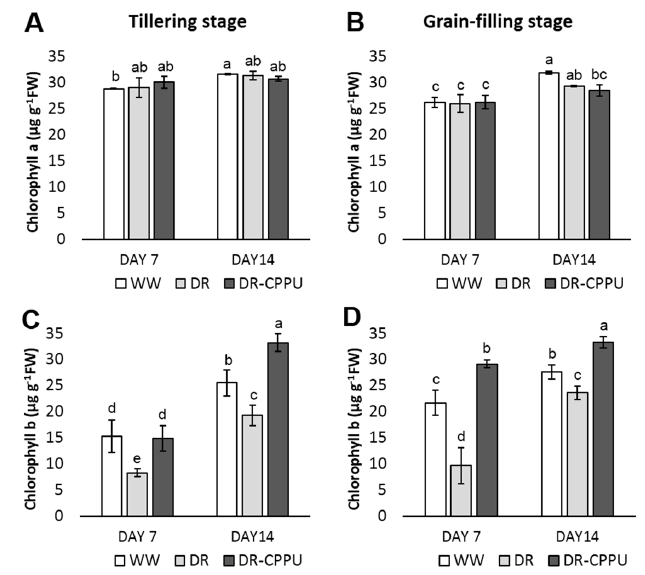
Figure 6. Contents of chlorophyll pigments ( µ g g − 1 FW), Chl a ( A , B ) and Chl b ( C , D ), quantified from rice leaves under di ff erent treatment conditions at tillering and grain-filling stages. WW = Well-watered plants (soil moisture tension of − 15 kPa), DR = Drought stressed plants (Soil moisture tension of − 55 kPa and − 72 kPa at day 7 and day 14, respectively), and DR-CPPU = Drought stressed plants, sprayed with 5 mg / L CPPU on day 6 of drought treatment. Error bars represent SD (standard deviation). Letters viz. a, b, c, d, e, over SD bars indicate the highly significant di ff erences of mean at p < 0.01 (**) as analyzed by Duncan’s Multiple Range Test (DMRT). To authenticate the effect of drought and synthetic cytokinin spray on photosynthetic pigments, we investigated the abundance intensities of two key enzymes, chlorophyll synthase and 7- hydroxymethyl chlorophyll a reductase (HCAR), involved in biosynthesis/degradation of chlorophyll pigments. Chlorophyll synthase, involved in the final step of the biosynthetic pathway of chlorophylls, catalyzes the esterification of chlorophillide a or b with phytyl or geranyl-geranyl pyrophosphate into chlorophyll a or b as final product in the chloroplast [70,71]. Reduced expression of chlorophyll synthase also instigates a feedback-controlled inactivation of the initial and rate- limiting step of the chlorophyll synthetic pathway in plants [72]. In our study, the abundance of chlorophyll synthase protein was severely affected by the drought exposure, whereas CPPU treated plants retained sufficient levels of this enzyme under drought stress (Figure 7A). Another enzyme involved in chlorophyll metabolism, HCAR, revealed contrasting abundance patterns under drought stress (Figure 7B). It showed enhanced abundance in drought stressed leaves and relatively low abundance in well-watered and CPPU treated plants under drought stress. HCAR belongs to the iron-sulfur flavoprotein group containing FAD and an iron-sulfur center [73]. It catalyzes the reduction of a hydroxymethyl group to a methyl group and thereby converts 7-hydroxymethyl chlorophyll to chlorophyll a in the chloroplast. Interestingly, 7-hydroxymethyl chlorophyll, which serves as substrate for HCAR, is derived from the NaBH 4 mediated reduction of chlorophyll b in the chloroplast [74]. Henceforth, HCAR has been categorized as a catabolic enzyme of the chlorophyll cycle that carries out the second and the last step in the conversion of chlorophyll b to chlorophyll a [75]. Previous studies in Arabidopsis and rice indicated that HCAR-overexpressing plants exhibited accelerated leaf yellowing and senescence due to the degradation of chlorophyll b in the chloroplast, whereas HCAR knockout mutants exhibited persistent green leaves during both dark-induced and natural senescence [76,77]. The abundance intensities of chlorophyll synthase and HCAR proteins clearly corroborate with the results of spectrophotometrically quantified Chl a and Chl b pigments. Consequent to the reduced abundance of chlorophyll synthase, it can be hypothesized that drought